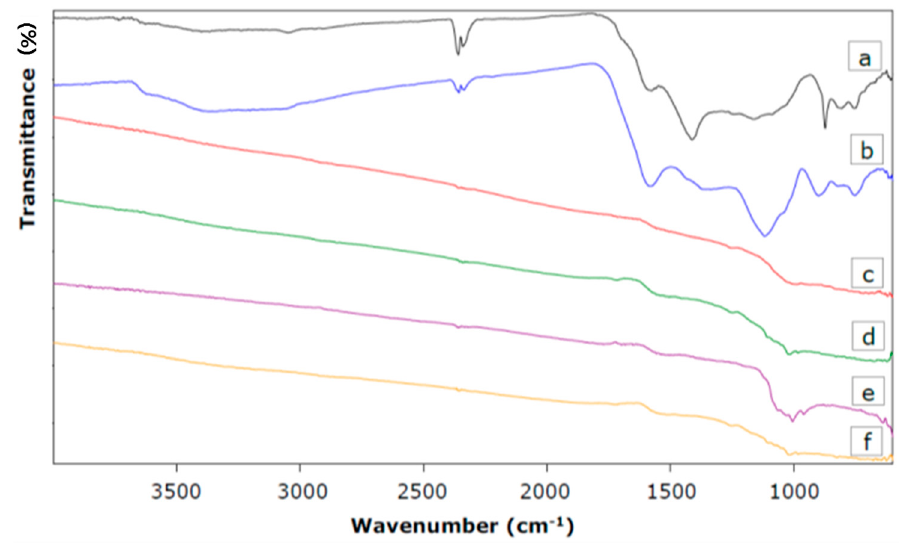
Figure 3. ATR-FTIR spectra of the solid residue from raspberry seed cake ( a ) and from rapeseed cake ( b ); of ACs produced from raspberry seed cake ( c ) and rapeseed cake ( d ) by CO 2 activation (C-900-120); and ACs derived from raspberry seed cake ( e ) and rapeseed cake ( f ) by steam activation (S-900-90, HCl washed in the case of rapeseed cake).